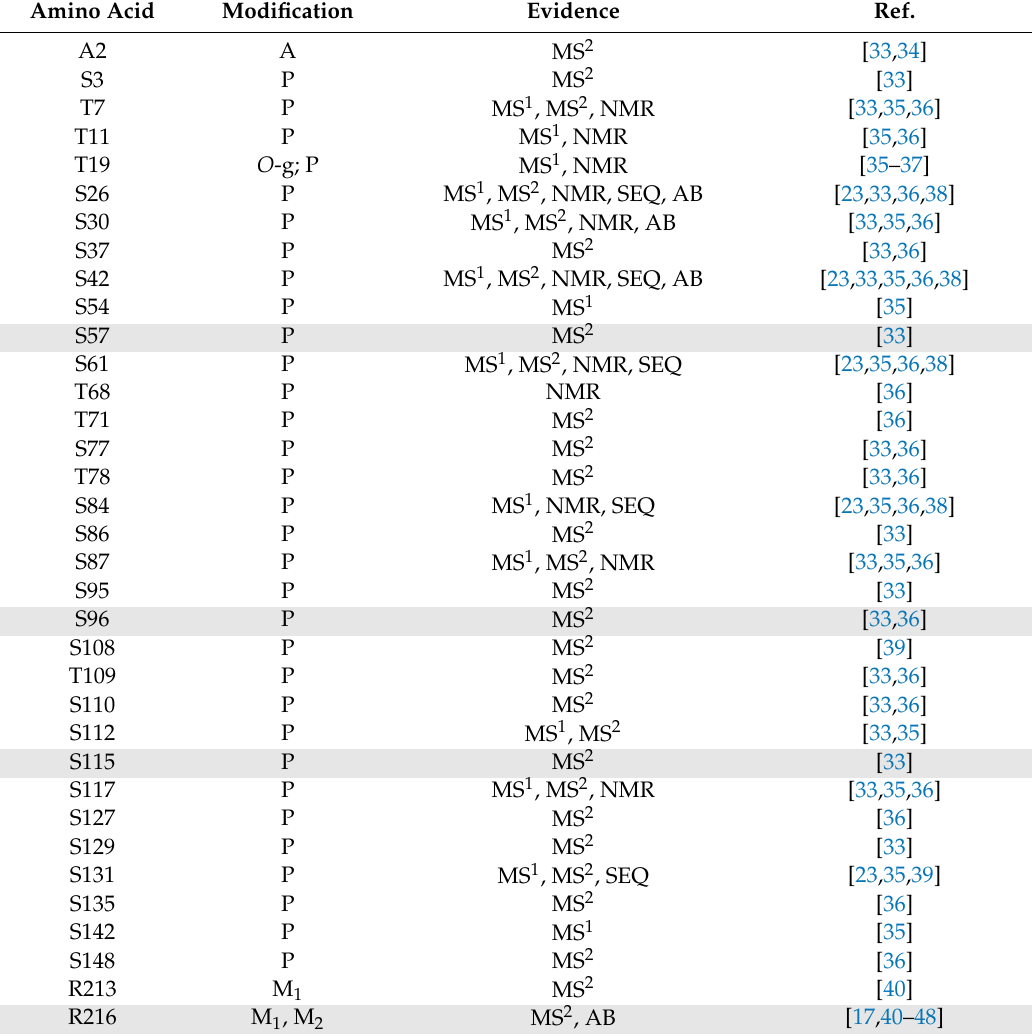
Table 1. Post-translational modifications (PTMs) of